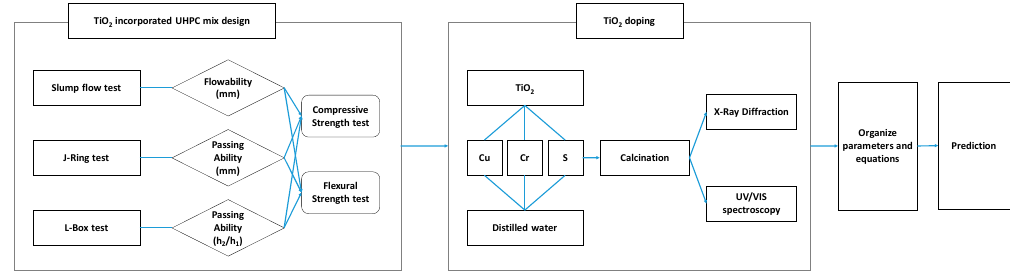
Figure 4. Research flow chart.